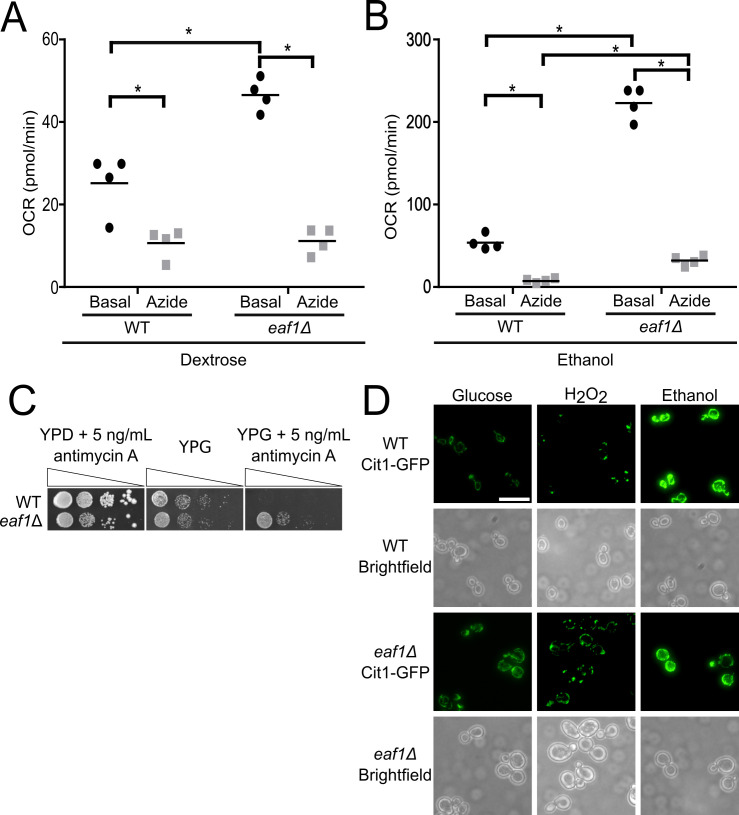
eaf1Δ mutants have functional mitochondria and are able to respond to biogenesis and fission signals.The oxygen consumption rate (OCR) of either WT or eaf1Δ cells was measured using the Seahorse Extracellular Flux Analyzer. After basal measurements, sodium azide was injected into the wells to shut off mitochondrial oxygen consumption and an additional set of measurements were taken. This was performed for (A) cells grown in dextrose media and (B) for cells grown in ethanol media for four biological replicates. ANOVA analysis was performed with a Tukey’s multiple comparison test comparing pairs of means. * = p < 0.05. Horizontal bars in the data represents the mean. (C) WT and eaf1Δ cells were serially diluted onto YP plates containing glucose (YPD) or the nonfermentable glycerol (YPG) in the presence of the mitochondrial complex III inhibitor antimycin A. (D) Mitochondrial responsiveness to environmental stressors was assessed by growing WT and eaf1Δ cells in the presence of ethanol to assess biogenesis or H2O2 to assess stress induced fission. Scale bar = 10 μm.